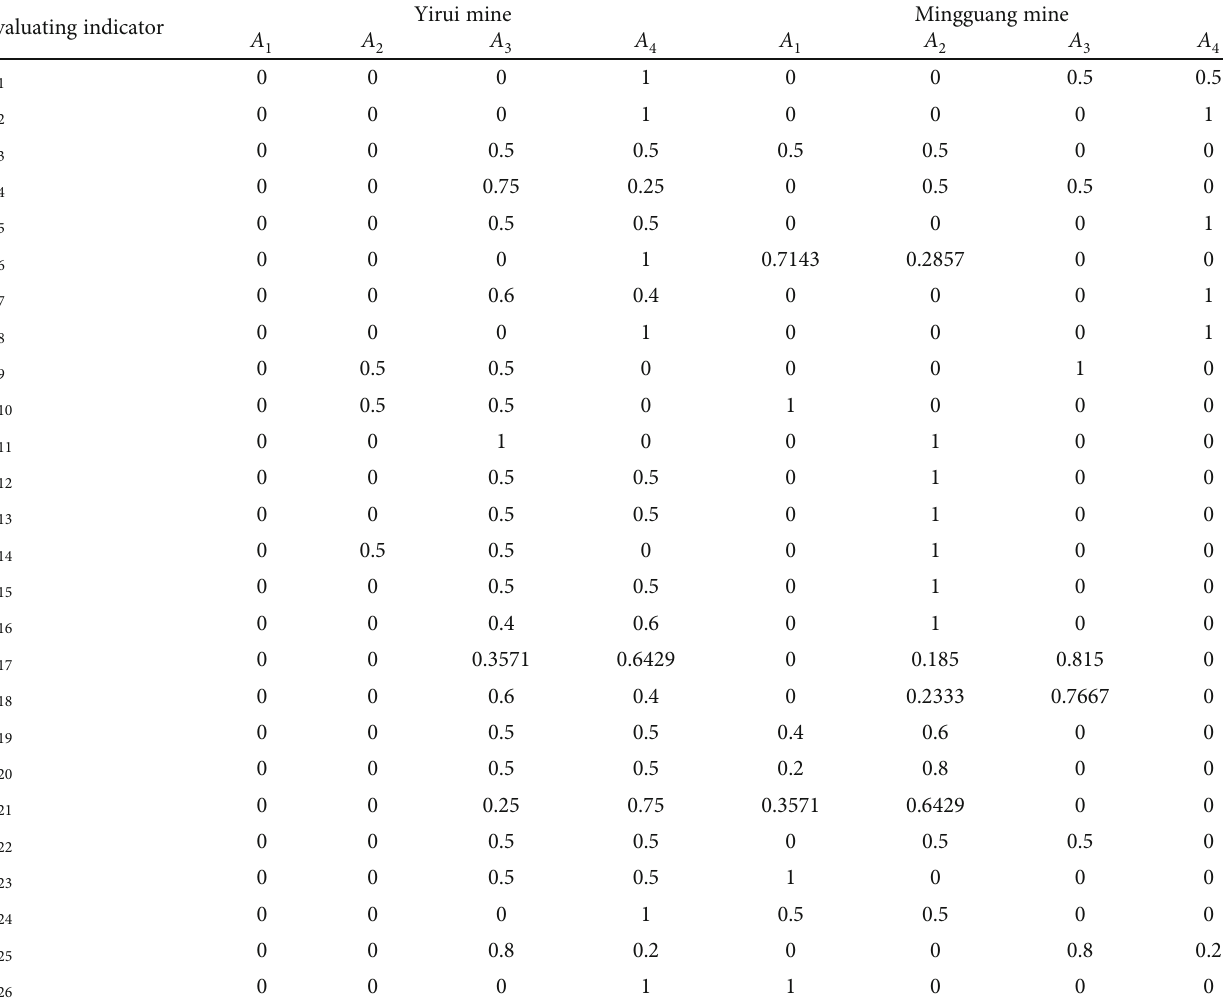
Table 8: Assessment matrixes of single indicator measure values for Yirui limestone mine and Mingguang limestone mine. Evaluating